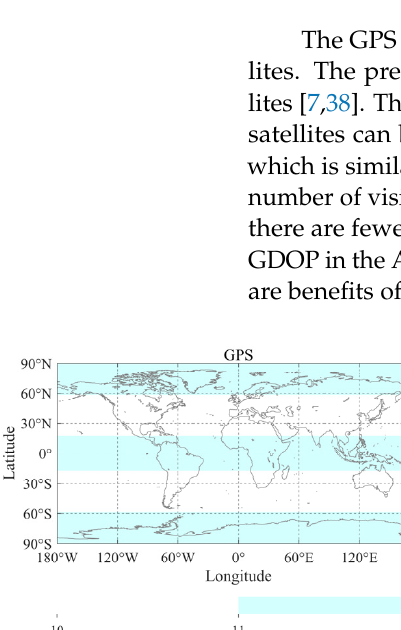
Figure 4. Satellite visibility and GDOP of GLONASS: ( a ) visible satellites of 24-GLONASS; ( b ) visible satellites of 30- GLONASS; ( c ) GDOP of 24-GLONASS; ( d ) GDOP of 30-GLONASS.